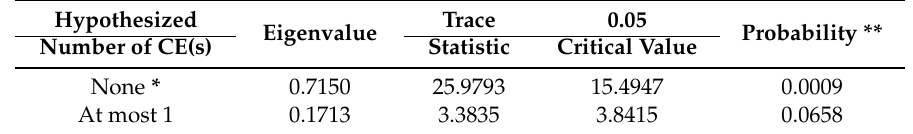
Table 2. Unrestricted Cointegration Rank Test (Trace).